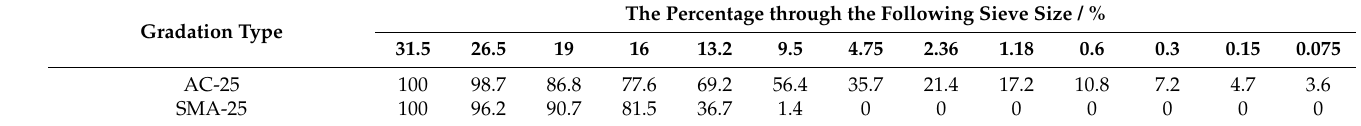
Table 5. Test gradation of AC-25 and